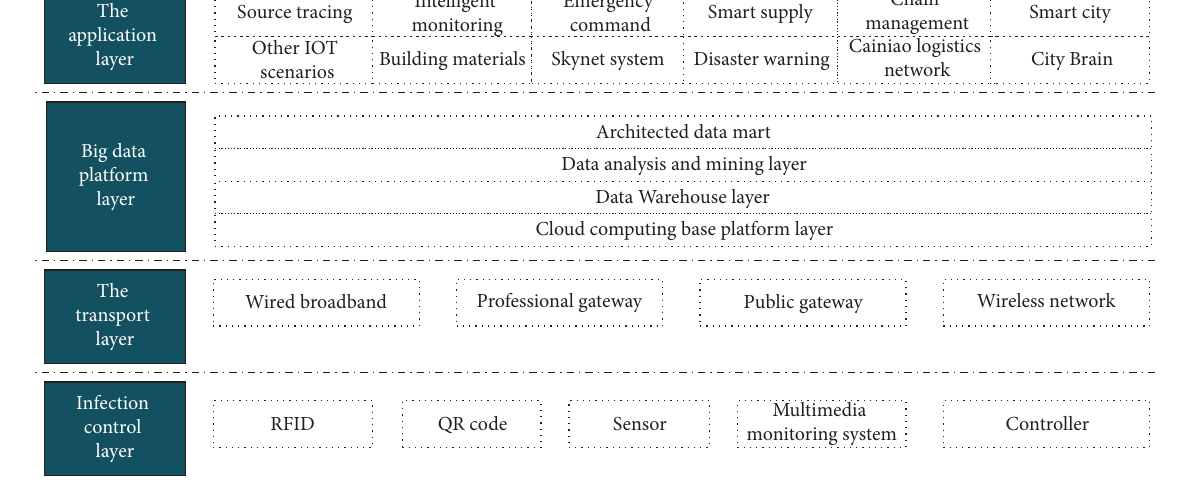
Figure 1: IoT architecture.